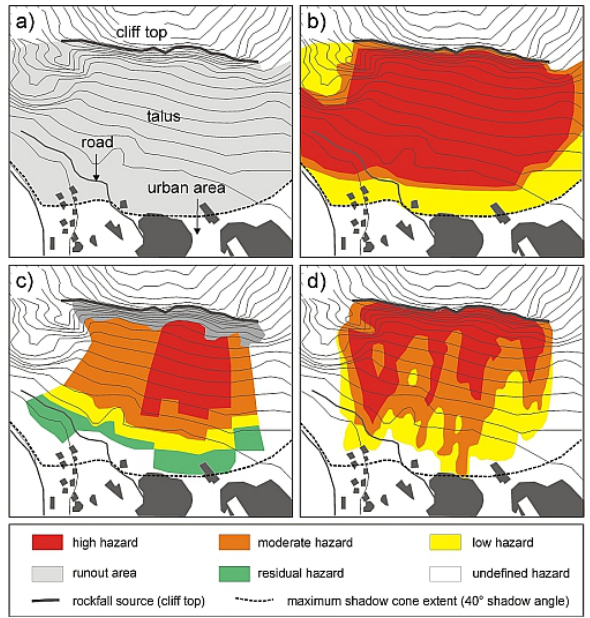
Fig. 3. Comparison of hazard maps derived for the area of Mt. S. Martino (Lecco, Italy; Jaboyedoff et al., 2001; Crosta and Agliardi, 2003) using different modelling approaches and zoning methods. (a) Maximum runout area estimated by a shadow angle approach using the code CONEFALL (Jaboyedoff and Labiouse, 2003); (b) hazard map obtained by applying the RHV methodology (Crosta and Agliardi, 2003) to the reach probability and kinetic en- ergy estimated by CONEFALL; (c) rockfall hazard map obtained by 2-D numerical modelling using the RHAP methodology (modified after Mazzoccola and Sciesa, 2000); (d) rockfall hazard map ob- tained by 3-D numerical modelling using the code HY-STONE and the RHV methodology (modified after Crosta and Agliardi, 2003). statistical techniques.